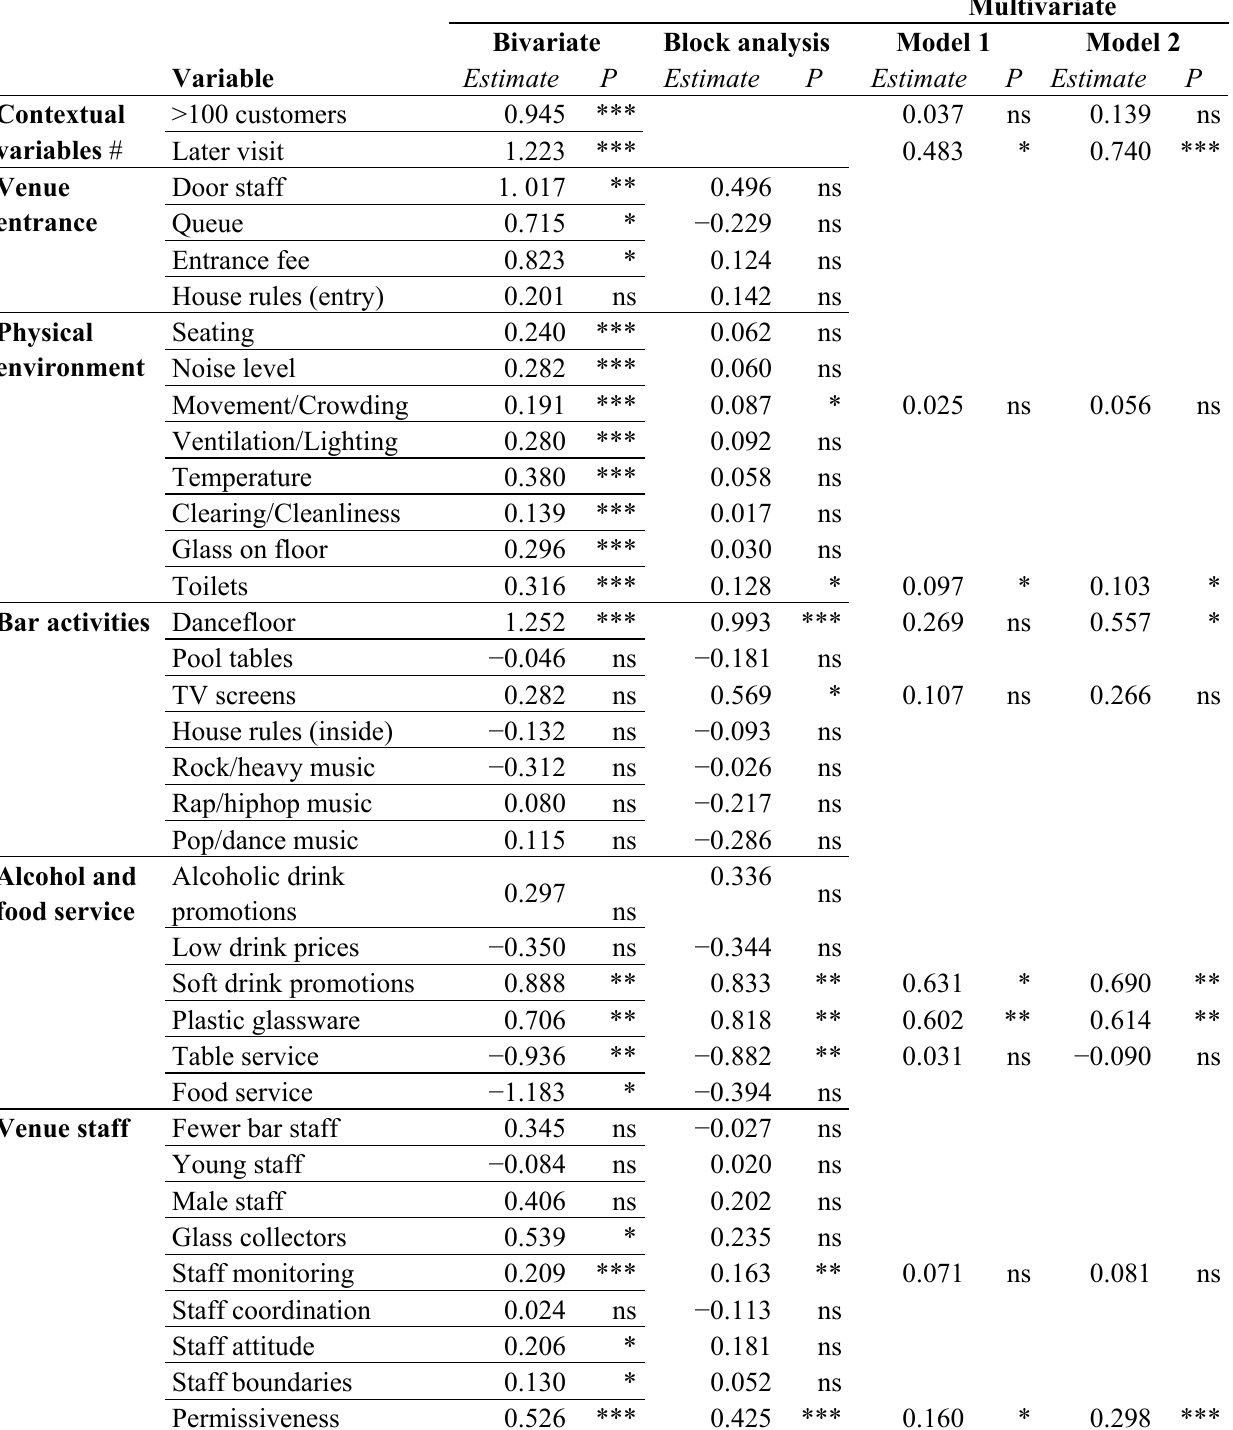
Table 3. Hierarchical modelling: Associations between environmental characteristics and customer intoxication